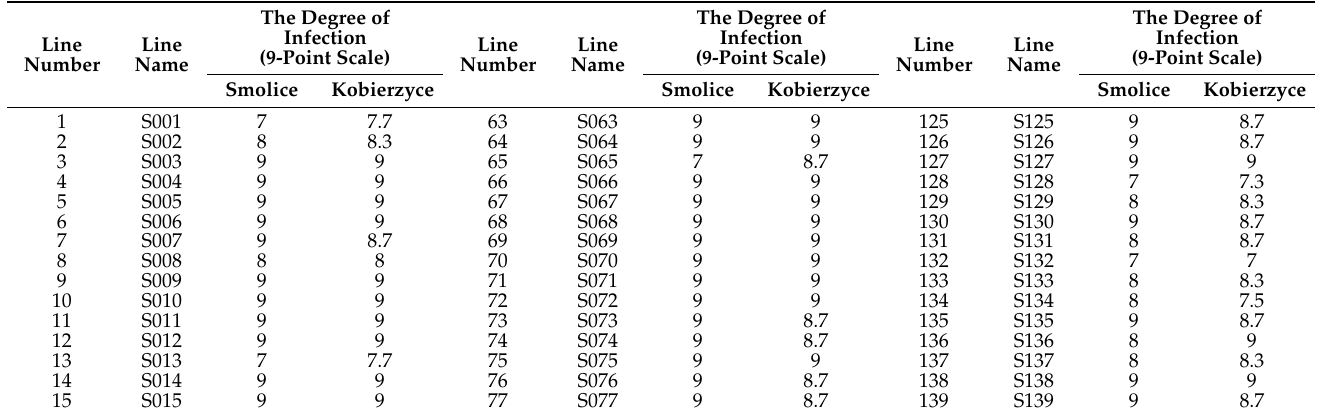
Table 1. The degree of infection of the maize line by the fusarium in Kobierzyce and Smolice (average of all observations